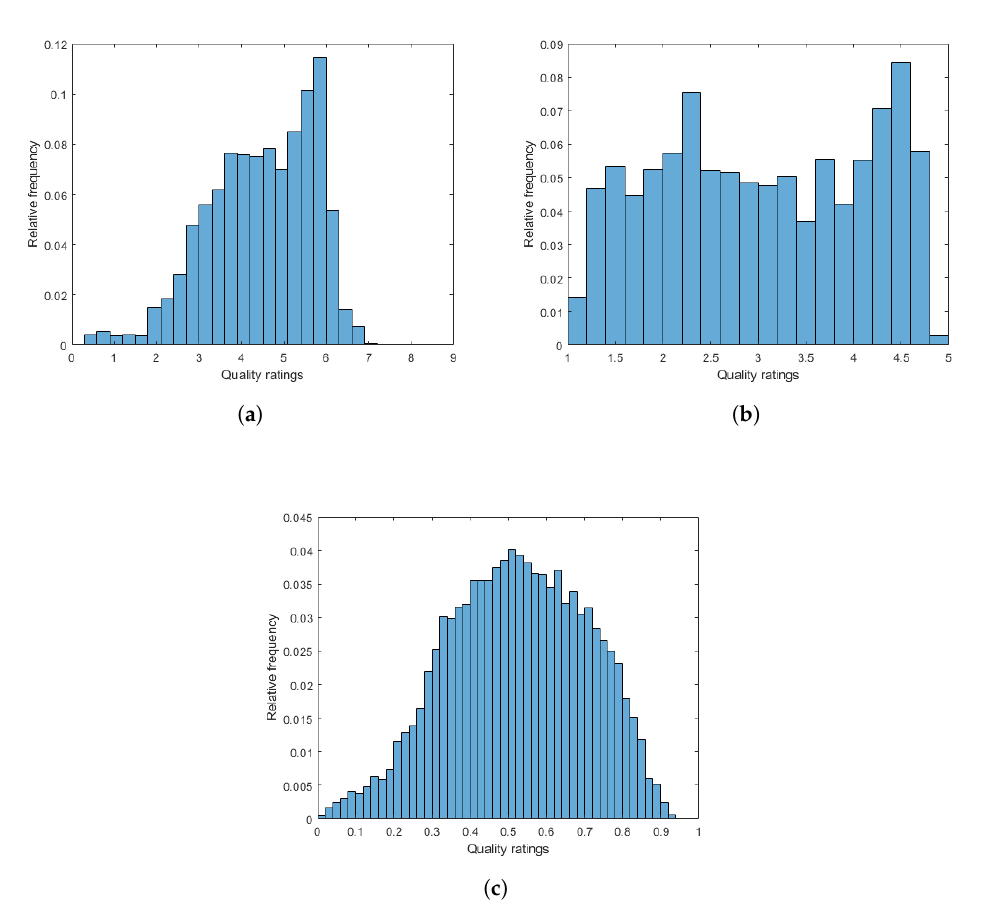
Figure 4. The empirical distributions of quality ratings in the considered IQA benchmark databases: